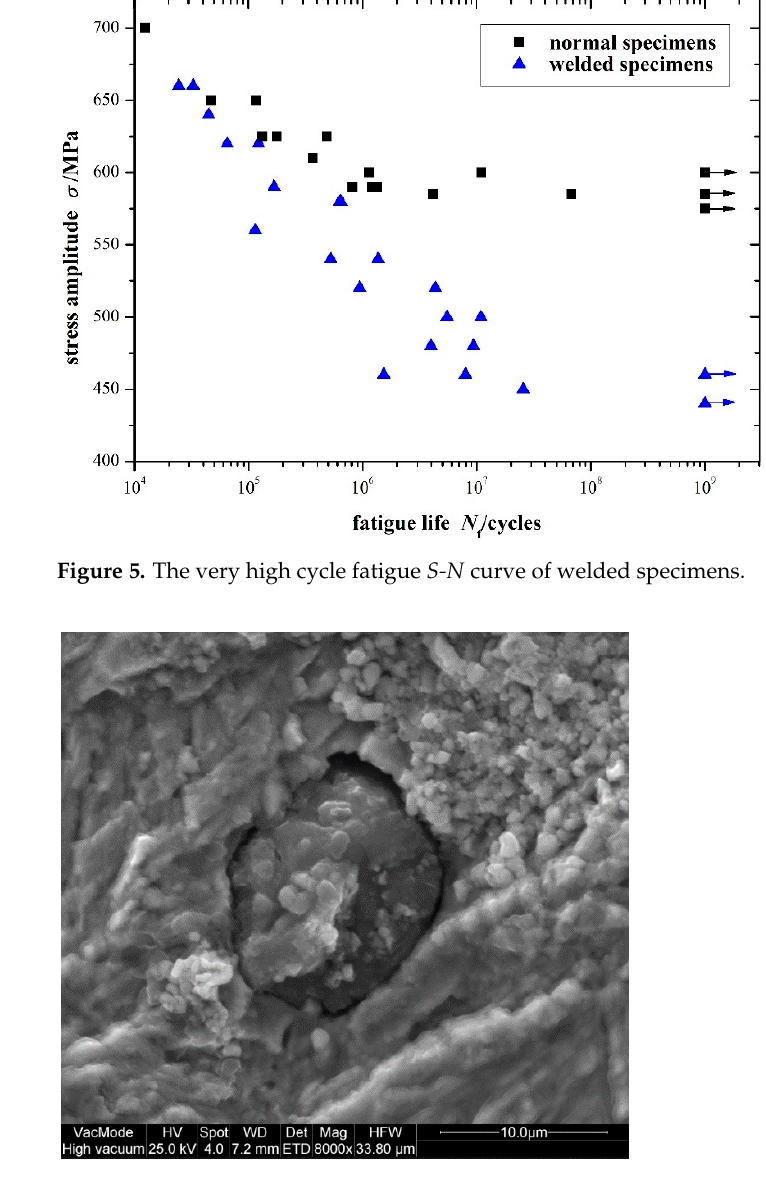
7 a = 520 MPa, N f = 4.25 × 10